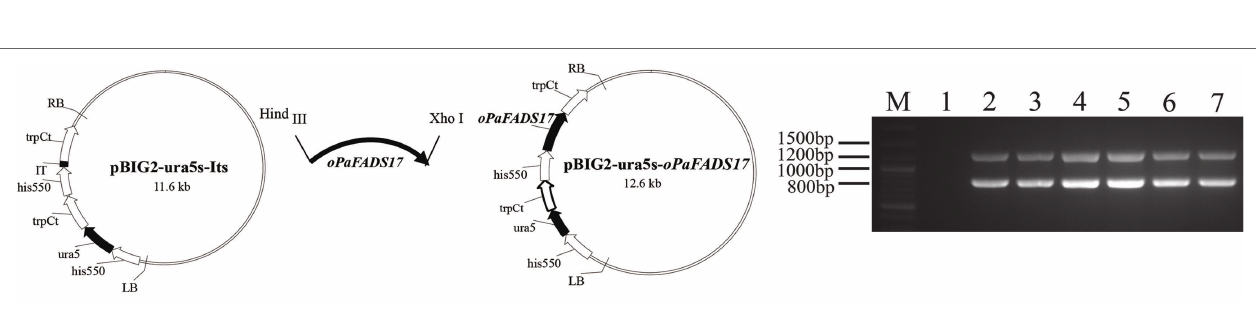
FigUre 5 | Construction of the binary vector pBIG2-ura5s- oPaFADS17 . The his 550 promoter fragment was derived from Mortierella alpina ATCC 32222. The trpCt transcription terminator region was derived from Aspergillus nidulans . LB, left border; RB, right border. M, marker; lane 1, M. alpina (negative control); lanes 2–7: M. alpina - oPaFADS17 -(1–6). Bands at 818 and 1,244 bp indicate the presence of the oPaFADS17 gene.